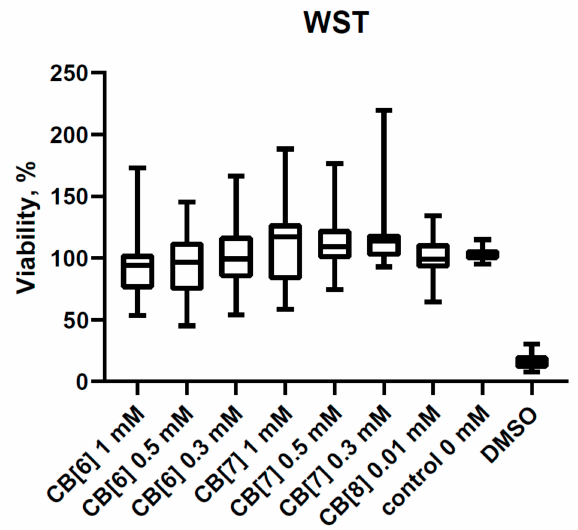
Figure 1. The viability of peripheral blood mononuclear cells (PBMCs) with or without cucurbit[n]uril (n = 6, 7, 8) at different concentrations. Data are presented as box-and-whisker plots, with boxes extending from the 25th to the 75th percentile, with a horizontal line at the median, while the whiskers extend to the lowest and highest data points (n = 13). Nanomaterials 2021 , 11 , x FOR PEER REVIEW